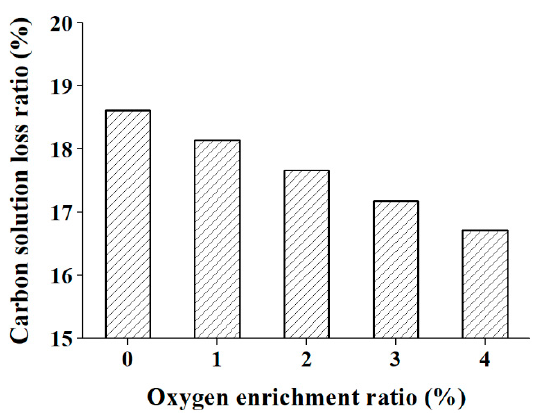
Figure 5. Carbon solution loss ratio at di ff erent oxygen enrichment ratio.